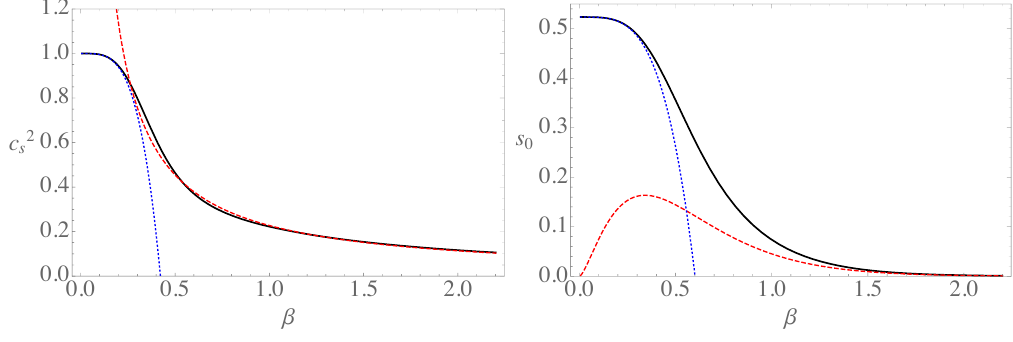
dP = dT Figure 3: Left: Speed of sound squared, c 2 , as a function of inverse temperature s T d 2 P dT 2 β in Ising Field Theory deformed by the σ operator in units with h = 1. The black, solid line is the exact result from integrability. Also shown are the leading large T result in conformal perturbation theory (blue, dotted) from (78) and the leading ≈ 1 small T result c 2 (red, dashed), where m is the mass of the lightest particle. 1 m 1 β s dP = 1 Right: Dimensionless entropy s as a function of β . Again, the black solid o T dT line is the exact result in the Ising Field Theory deformed by σ with h = 1, shown together with the leading conformal perturbation theory result (blue, dotted), and − β m 1 ( β m ) 3 / 2 ≈ e (cid:112) 1 leading small T result s (red, o 2 π